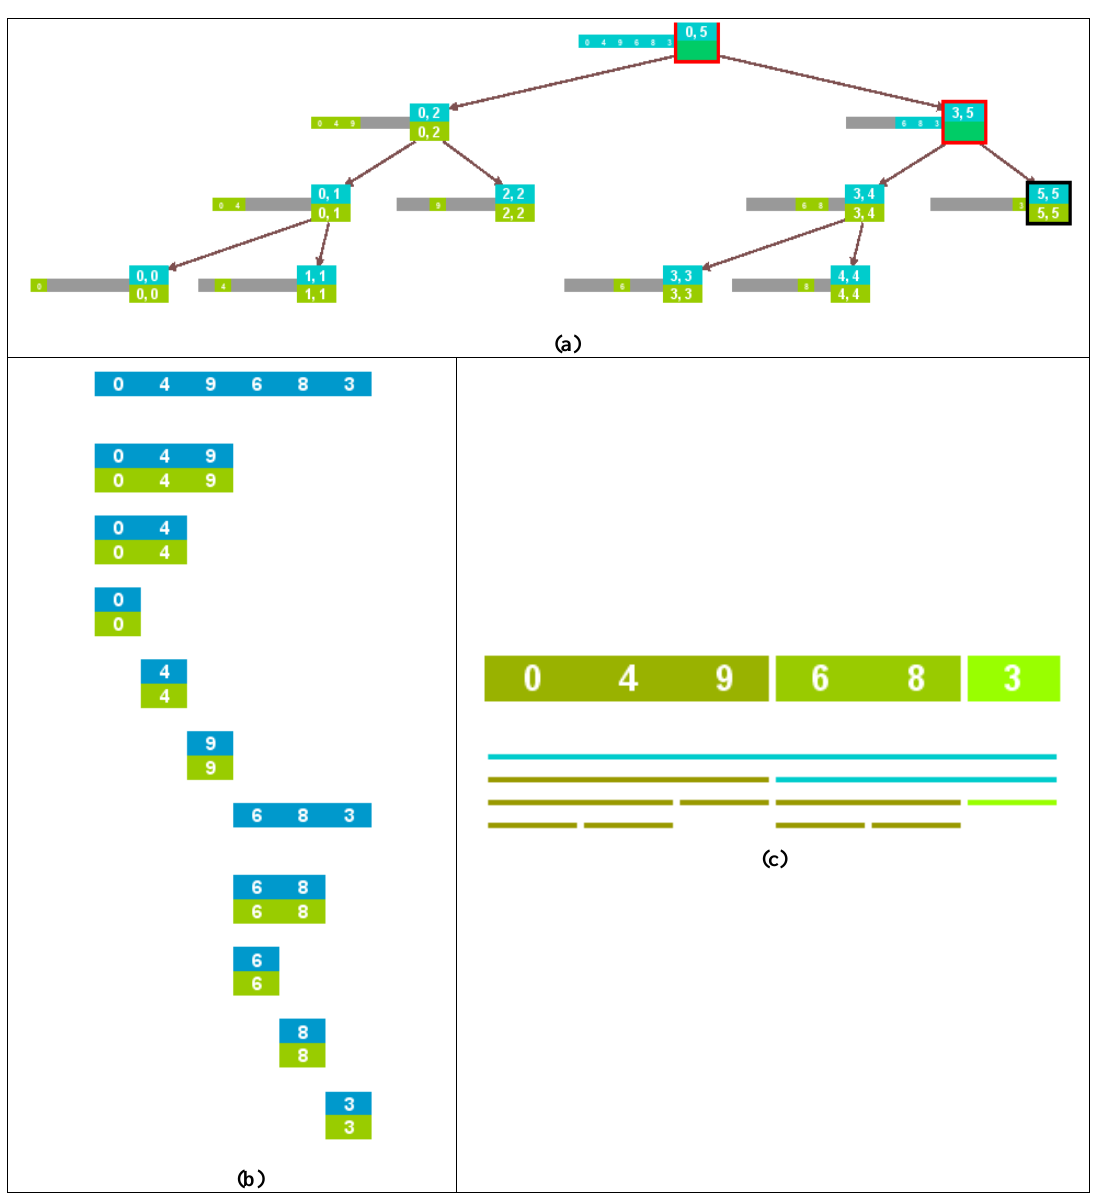
Figure 2. Three visualizations of mergesort ({0,4,9,6,8,3}): (a) divide-and-conquer recursion tree, (b) sequence of visualizations of a data structure, and (c) colored data